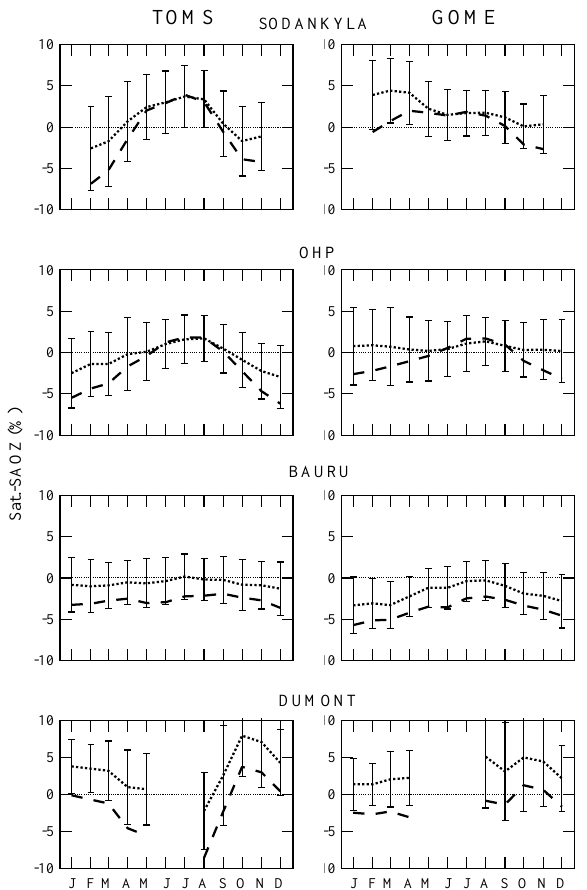
Fig. 11. Seasonal variation of the satellite-SAOZ relative difference (dashed lines: SAOZ V1, dotted lines: SAOZ V2). From top to bot- tom: Sodankyla, OHP, Bauru, and Dumont d’Urville. Left: TOMS, right: GOME-GDP4. The error bars correspond to the 1 σ devia- tions, which increase during the winter, particularly at high